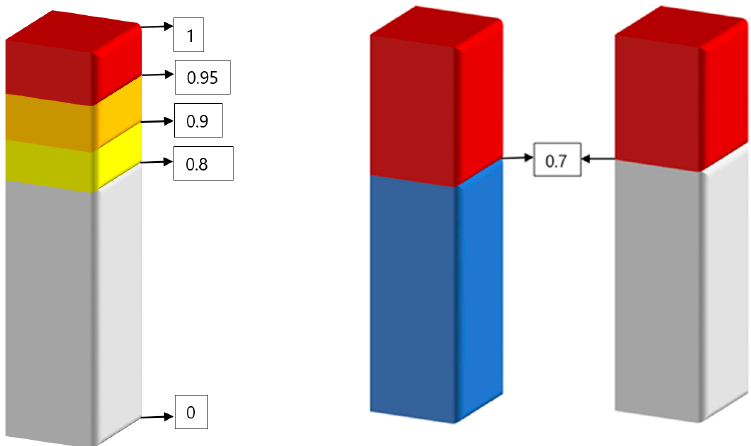
Figure 9. Demonstration of the developed rectangular gauge on a 0–1 scale for overload situation management (left), and combination of operator loads for overload situation management (right).